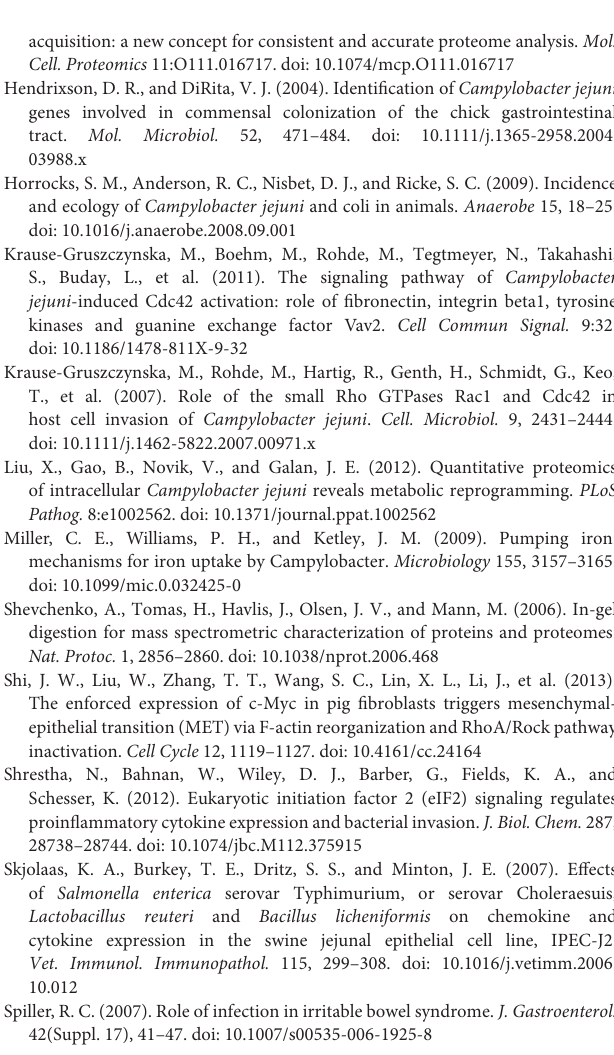
Table S1 | Differentially expressed proteins in both cell lines. Table S2 | Biological functions IPA results in both cell lines. Table S3 | Canonical pathways IPA results in both cell lines. Table S4 | C. jejuni proteins identified in INT-407 cell line. Table S5 | C. jejuni proteins identified in IPEC-1 cell line. Table S6 | String proteins